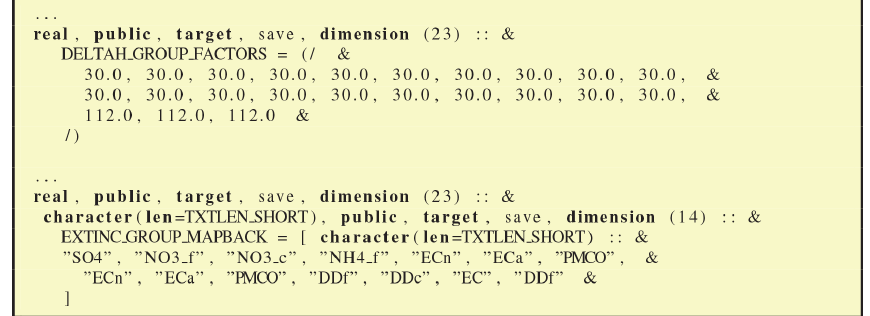
Figure 12. Further lines from CM_ChemGroups_mod.f90 , illustrating the numerical or string values associated with class (ii) compound groups; see Sect. 6.1.2.